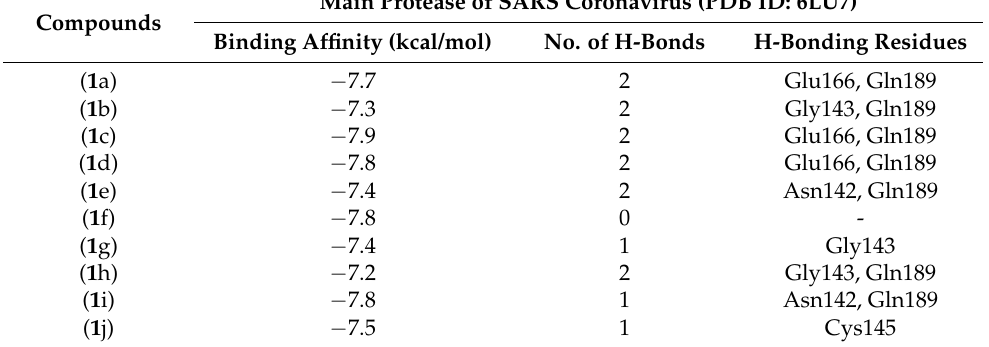
Table 2. Molecular docking interaction of compounds ( 1 a– 1 j) against protease of SARS coronavirus in complex with α -ketoamide (PDB ID: 6LU7). Main Protease of SARS Coronavirus (PDB ID: Compounds